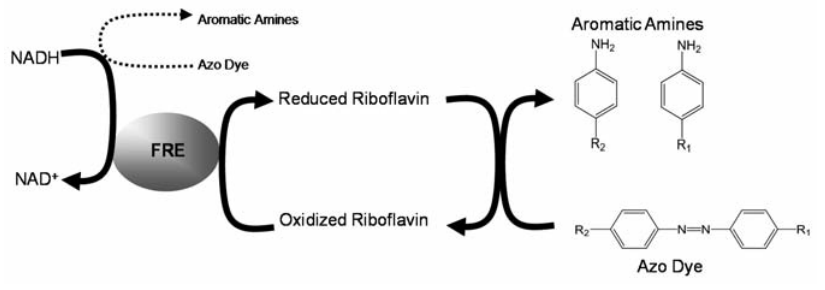
Figure 4. Proposed scheme depicting the reduction of an azo dye in the Fre system medi- ated by nicotinamide adenine dinucleotide (NADH) and riboflavin, reproduced (with slight modifications) from Field and Brady (2003), with permission. Dotted line indicates the non-enzymatic reduction by